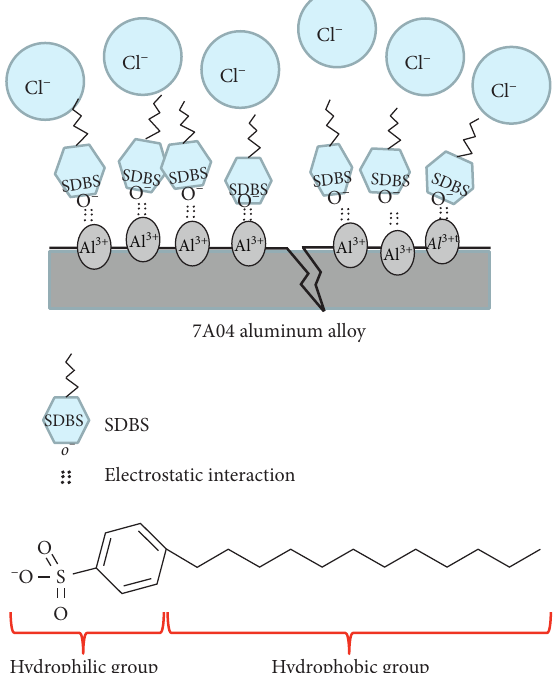
Figure 16: Schematic diagram of the corrosion inhibition mech- anism of